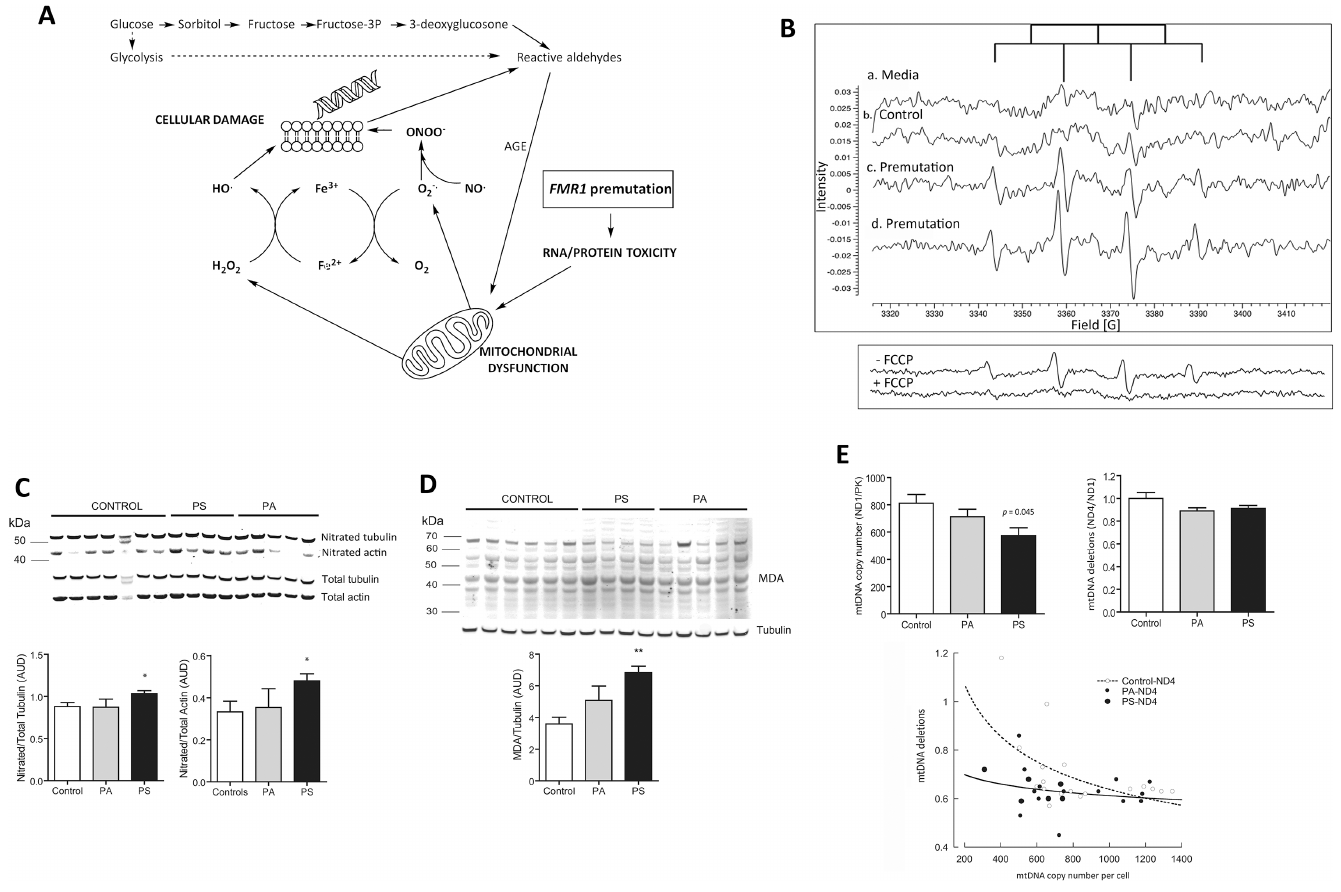
Figure 1. Redox biology pathways in premutation carriers. (A) Increases in mitochondria-derived superoxide anion production can lead to the formation of the highly reactive species resulting in biomolecule damage. In parallel, hyperactivation of the polyol pathway— usually associated with mitochondrial dysfunction—leads to excessive accumulation of sorbitol and fructose contributing to increases in cytosolic [NADH]/[NAD + ] ratios reducing the glucose flux via glycolysis and pentose phosphate pathway. This scenario impacts the mitochondrial [NADH]/[NAD + ] leading to the generation of “reactive aldehydes” and oxidatively modified proteins or advanced glyca- tion end-products. (B) Electron paramagnetic detection of free radicals in fibroblasts. Aliquots of cells from control and two premutation donors supplemented with deferoxamine, DMSO and DMPO were taken within 10–15 min after the addition of the spin trap. A weak EPR background signal was detected with cell culture media alone (a), which was higher upon addition of control cells (b). This latter signal was constituted by a quartet with an intensity ratio of 1:2:2:1 and hyperfine splitting constants a N = a H β = 14.9 G for N and H β con- sistent with the detection of DMPO-hydroxyl radical adduct, further confirmed by spectra simulation. Cells from two premutation carriers exhibited EPR spectra similar to that of controls constituted solely by hydroxyl radical (c) or by a combination of hydroxyl and a second adduct at a ratio of 19 to 1 (d). This secondary adduct ( a N = 16.4 G and a H β = 23.3 G) indicated the presence of DMPO-methyl adduct which resulted from the quenching of methyl radical (formed from the reaction between hydroxyl radical and DMSO) by DMPO. Lower panel: Representative EPR spectra of a cell line from a carrier with and without the addition of FCCP. (C) Representative Western blot image of 3-nitrotyrosine content in tubulin and actin of fibroblasts from controls, asymptomatic (PA) and FXTAS-affected or symptomatic (PS) premutation carriers. Intensity of nitrated actin and tubulin (expressed as arbitrary units of densitometry, AUD) were normalized by their respective total protein. ANOVA followed by Bonferroni was performed when comparing controls, PA and PS. * p < 0.05 versus con- trols. (D) Representative Western blot image and correspondent densitometry of MDA-protein adducts from controls and FXTAS-affected (PS) and unaffected (PA) carriers. ANOVA followed by Bonferroni’s post hoc test was used for the statistical analysis. * p < 0.005 versus controls. (E) Mitochondrial DNA copy number and deletions in control and premutation fibroblasts and correlations between these outcomes. P values were obtained with ANOVA followed by Bonferroni’s post hoc test. For correlations: Pearson ′ s r value = –0.500 and –0.244 ( p = 0.034 and 0.230) for controls and premutation